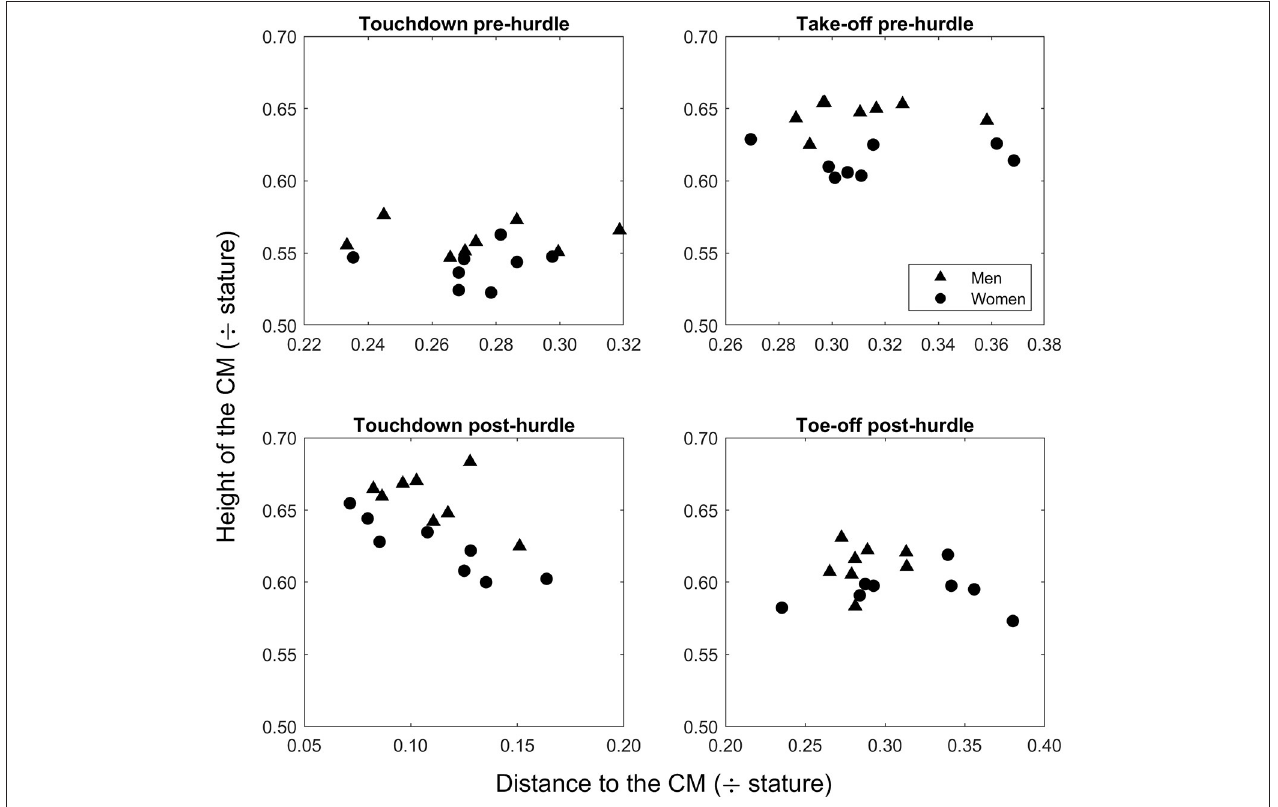
FIGURE 3 | Stature-normalized values for the height of the CM for each man and woman at touchdown and toe-off in the stance phases pre- and post-hurdle.